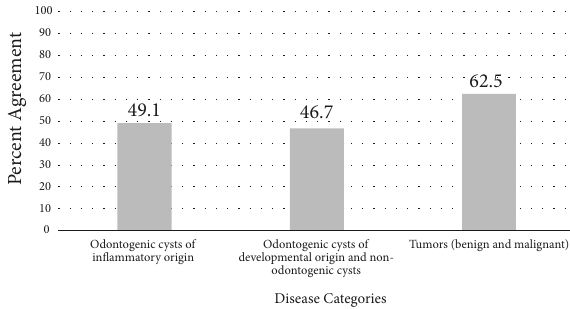
Figure 3: Percent agreement between histopathologicdiagnosis and radiographic interpretation based on disease